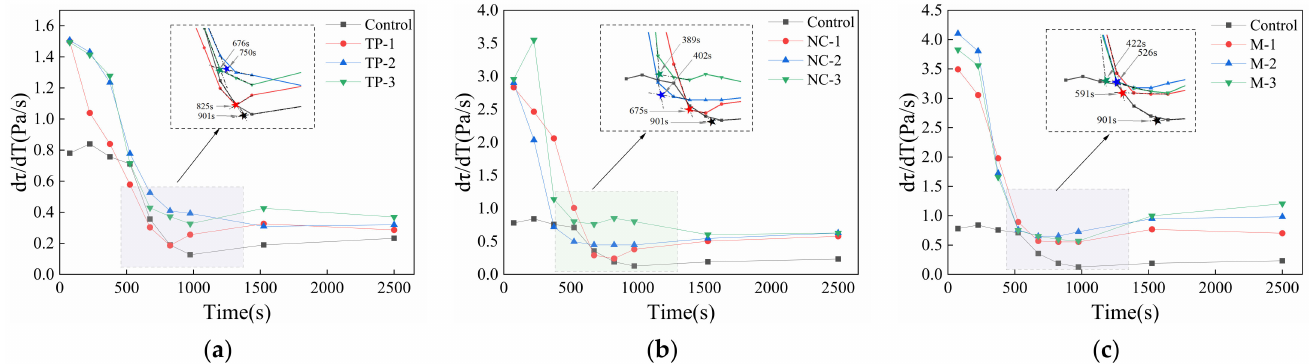
Figure 13. The RST development with time of printed materials with ( a ) single-doped TP, ( b ) doped NC and 3‰ PCE and ( c ) double-doped TP and